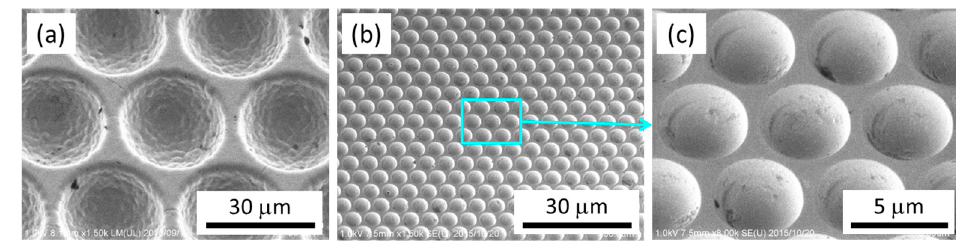
Figure 2. Scanning electron microscope (SEM) images of the microlens arrays (MLAs) in the Ni concave molds all shown as 30 ° -tilted views. ( a ) 33- μ m-pitch MLA, ( b ) 5- μ m-pitch MLA, and ( c ) magnified view of 5- μ m-pitch MLA.